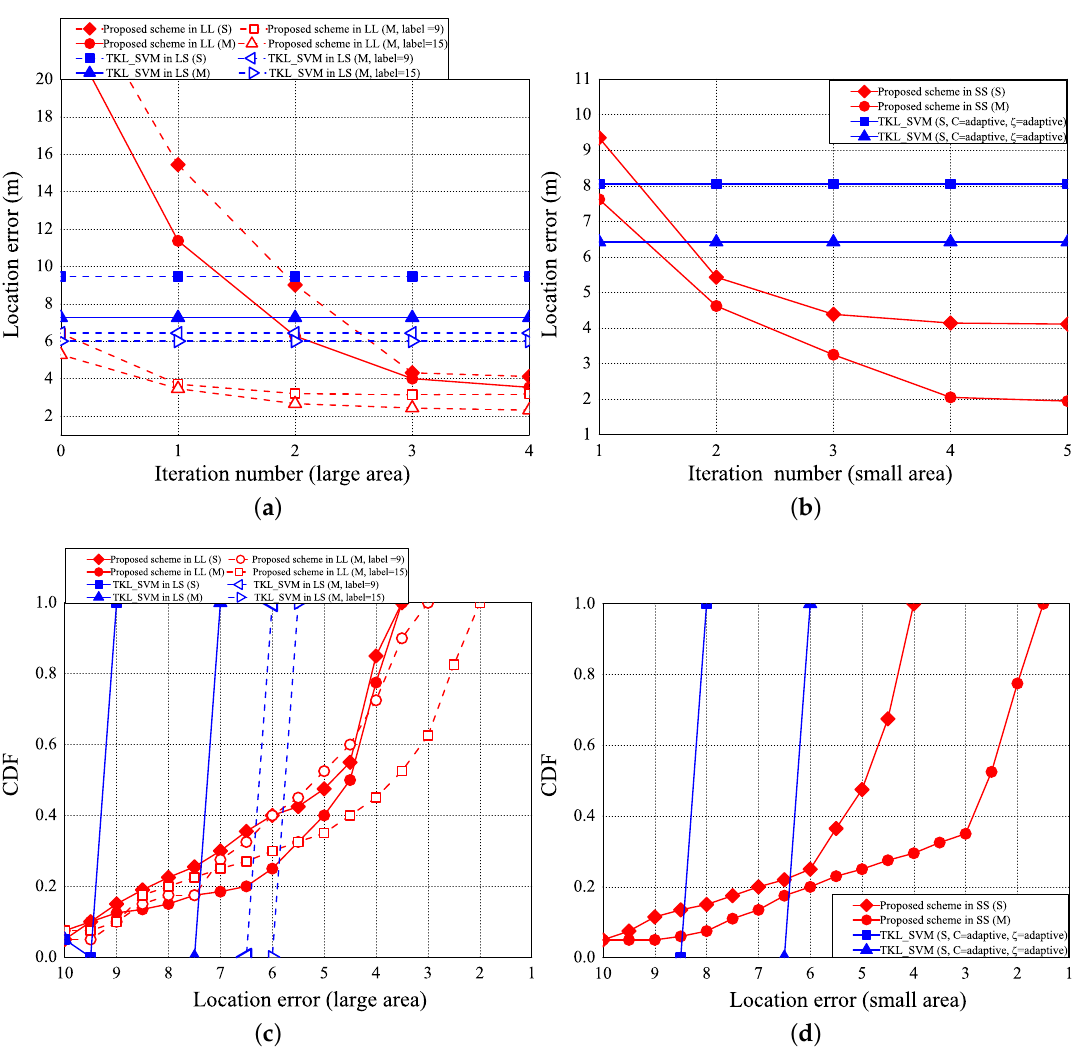
Figure 13. ( a ) Localization error (LL,LS) vs. number of iterations; ( b ) localization error (SS) vs. number of iterations; ( c ) CDF vs. localization error (LL,LS); ( d ) CDF vs. localization error